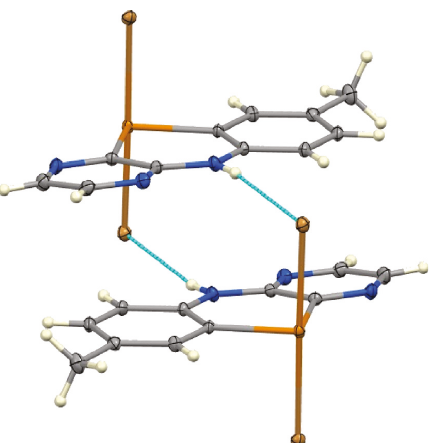
Figure 5: ORTEP plot of dimer of 5,5-dibromo-7-methyl-10 H - pyrazino